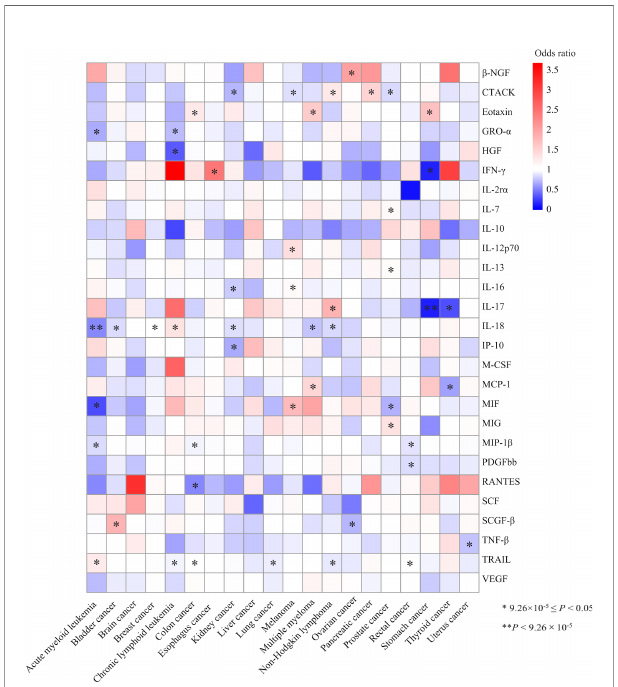
FIGURE 2 | Heatmap of the associations of the 27 cytokines with the risk of 20 site-speci fi c cancer from the inverse variance weighted (IVW) method. One asterisk indicates the suggestive evidence for a potential causal association (9.26×10 -5 ≤ P < 0.05), while two asterisks denote that the associations were statistically signi fi cant after multiple comparison correction ( P <9.26×10 -5 ). Colour is scaled based on the odd ratio (OR) of the MR association